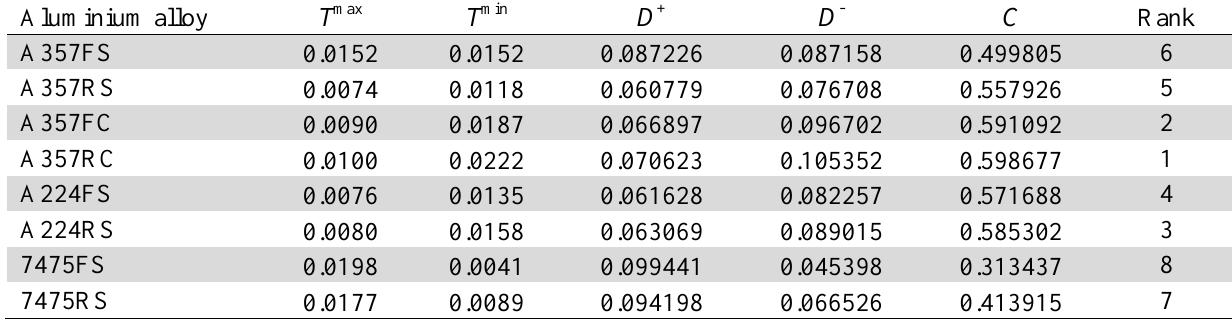
Ranking of aluminium alloys Aluminium